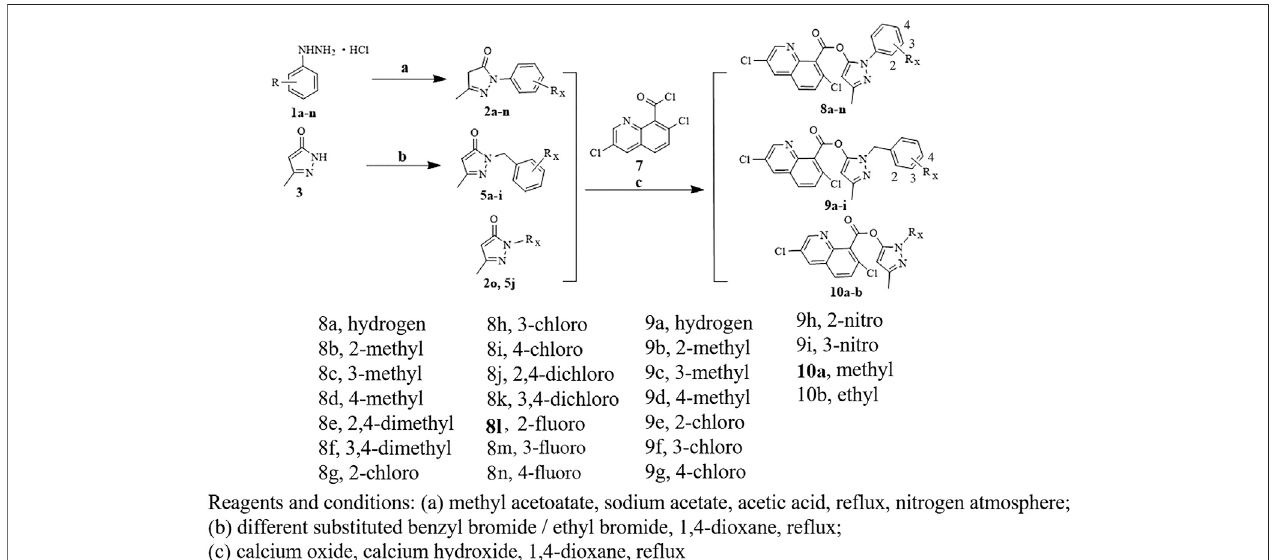
FIGURE 3 | Synthesis route to target compounds 8a-n, 9a-i, and 10a-b.